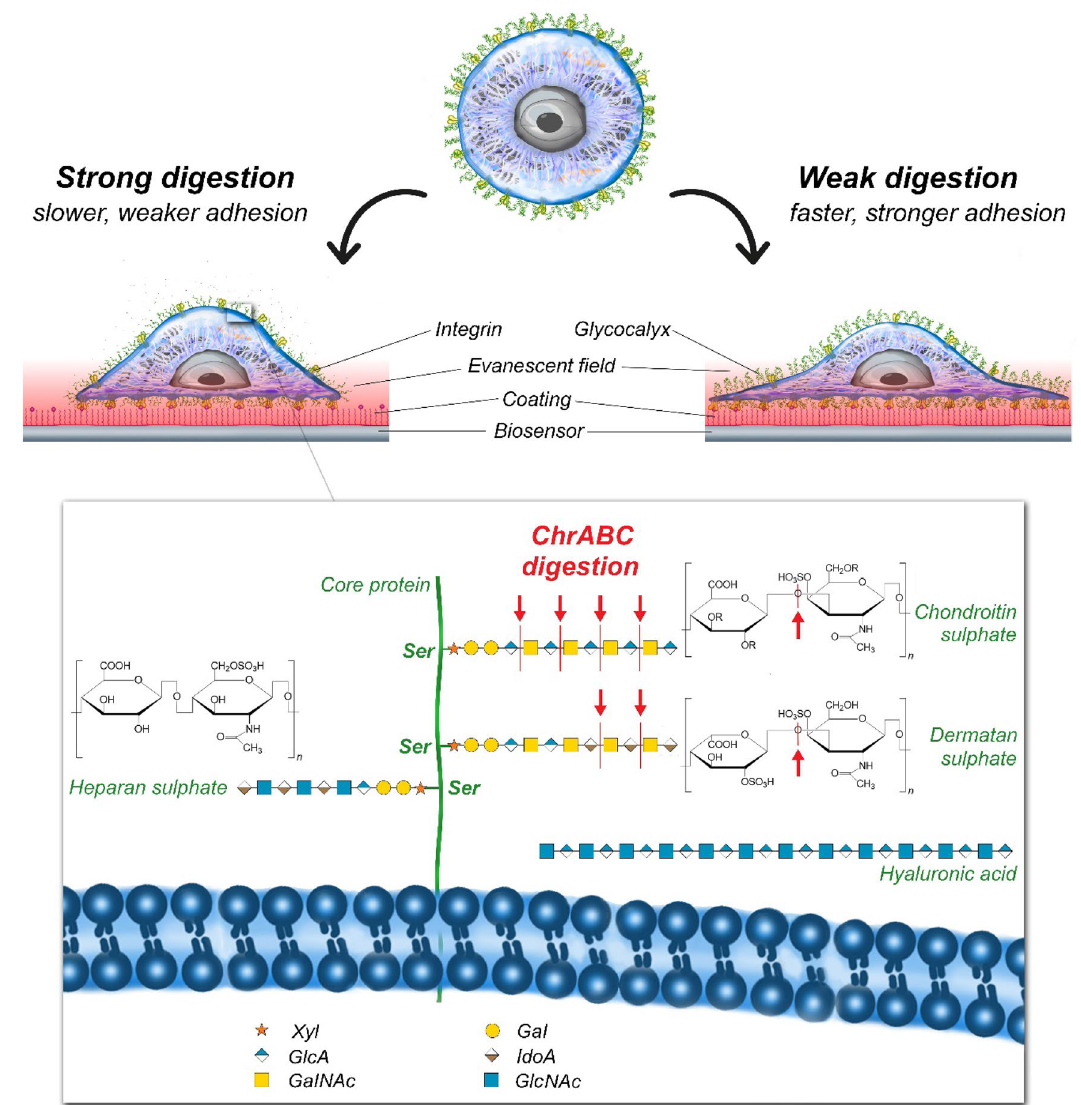
6-sulfate, but it can act slowly on hyaluronate as well 49,59,60